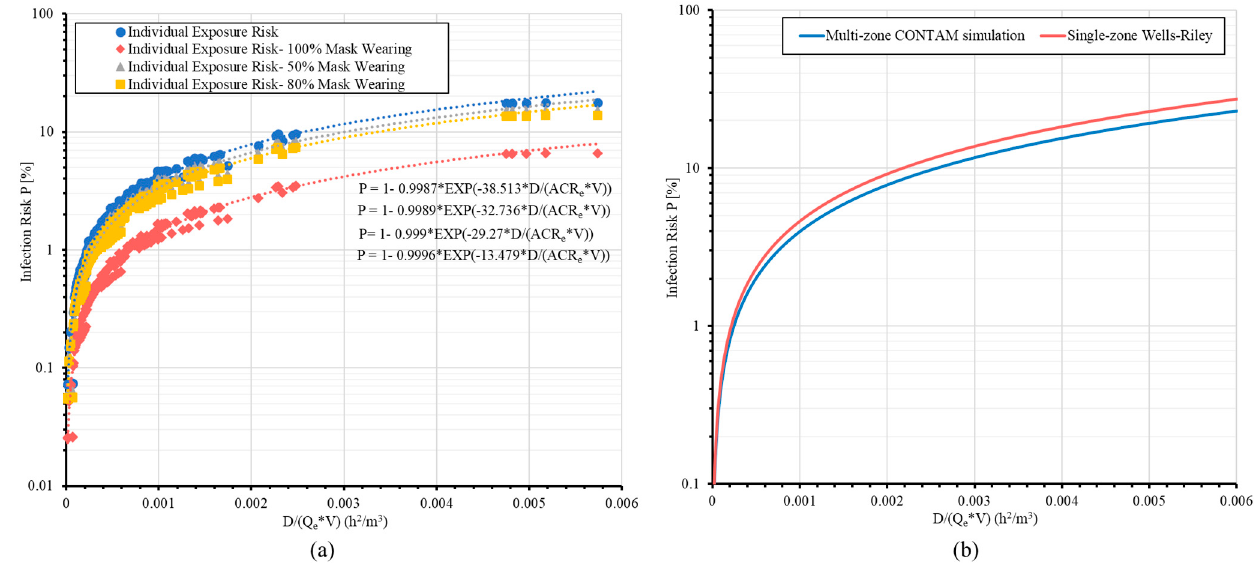
Figure 15. Relationship between individual infection risks and D/(Q e × V) (Q e —Equivalent air change rate (per hour); V—Volume; D—Duration). ( a ) Different mask-wearing scenarios. ( b ) Comparisons between multizone modeling and single-zone Wells–Riley.